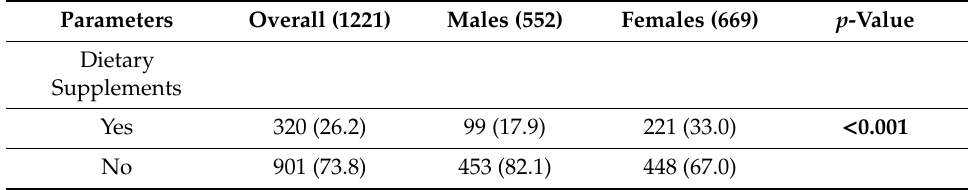
Table 1. Prevalence of dietary supplement use among